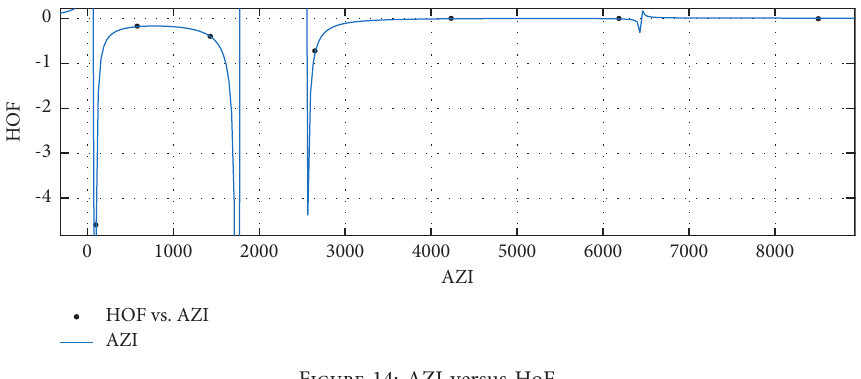
Figure 14: AZI versus HoF.